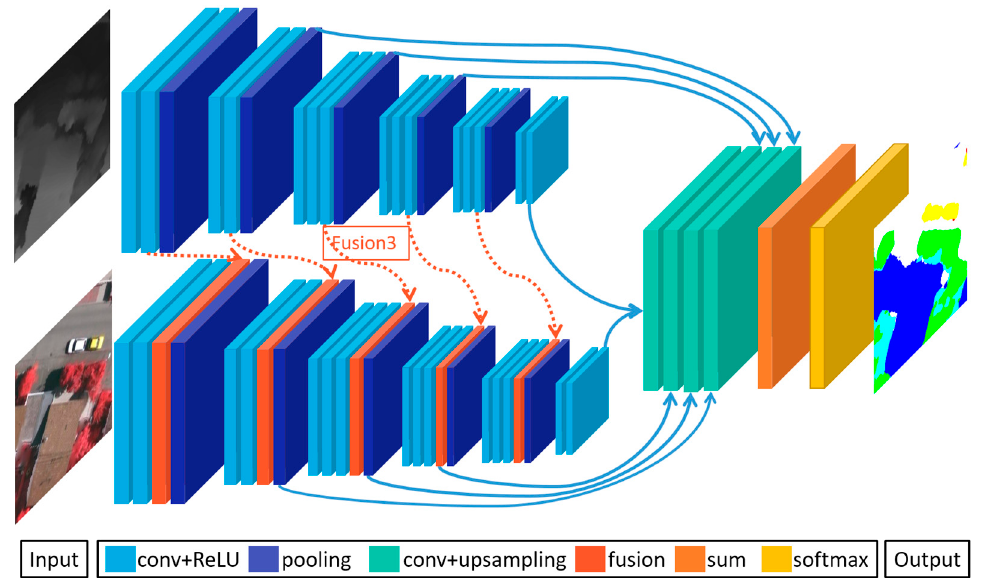
Figure 2. Fusion model incorporating multi-modal remote sensing data: Imagery and elevation. Fusion3 means that the dual streams (elevation and color) are fused in layer 3, the same holds for Fusion1 up to Fusion5. The fusion strategy works element-wise after the ReLU layer.